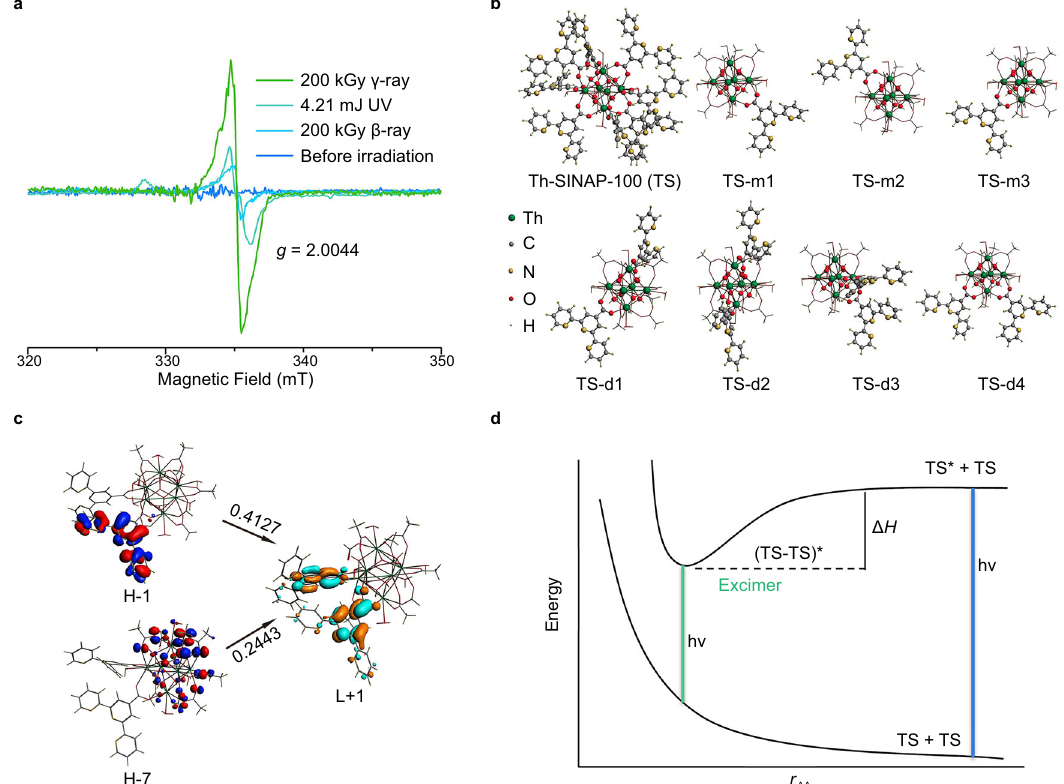
Fig. 5 Mechanism of photochromism and photoluminescence modulation. a EPR spectra of Th-SINAP-100 before and after irradiation. b Optimized structures of the experimentally synthesized complex and selected simpli fi ed models of Th-SINAP-100 (TS). c Orbital diagrams of the 364 nm electron transitions for TS-d1 from the TD-DFT calculations. d The formation of excimer (TS-TS)* that is stabilized by charge transfer, along with the light emitted by (TS − TS)* and TS* +